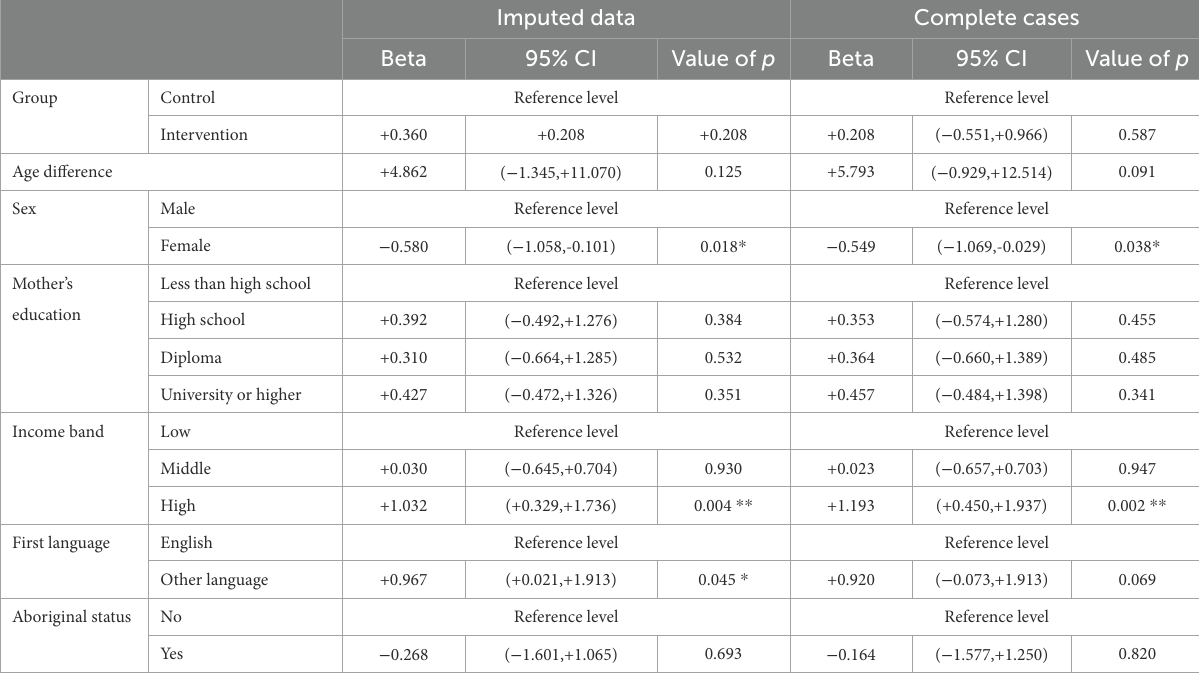
TABLE 7 Results of the regression model of difference between pre-and post-intervention DAS early number concepts scores; models fitted to multiply imputed data ( N = 1,134) and to complete cases only ( N =